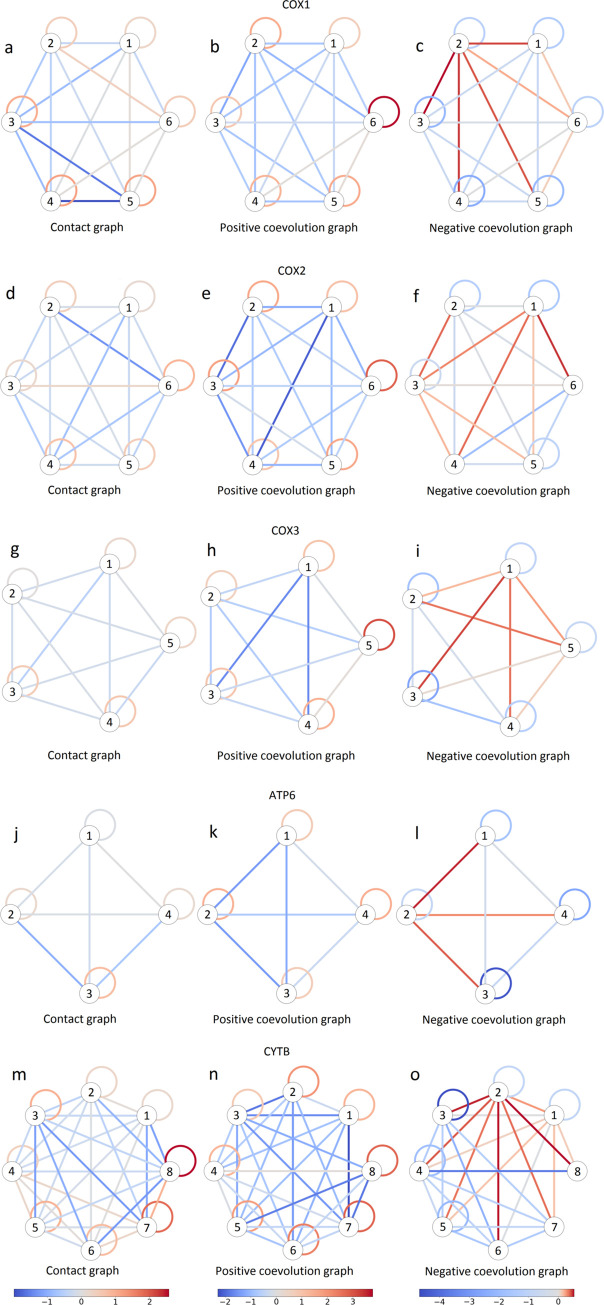
Schematic representation of contact and coevolution graphs for COX1 (a-c), COX2 (d-f), COX3 (g-i), ATP6 (j-l) and CYTB (m-o) proteins.Left column (a, d, g, j and m), contact graphs; middle column (b, e, h, k and n), positive edges in coevolution graphs; right column (c, f, i, l and o), negative edges in coevolution graphs. Each group of coevolving sites is represented by a circle. Links connecting circles represent between-group edges, and links connecting a circle to itself represent within-group edges. The color represents the difference of logarithms of the number of edges (left column) or sum of the weights of edges of the corresponding type (center and right columns) and their expected values obtained from a random model used by the vertex clustering algorithm [46]. For contact graphs, groups of coevolving sites are enriched in contacts on the protein structure: the number of edges connecting sites within a group is greater than expected from the random model. For coevolution graphs, the groups of coevolving sites have larger normalized total weights of positive edges within groups than expected from the random model; by contrast, negative edges tend to have greater than expected normalized total weights between groups.